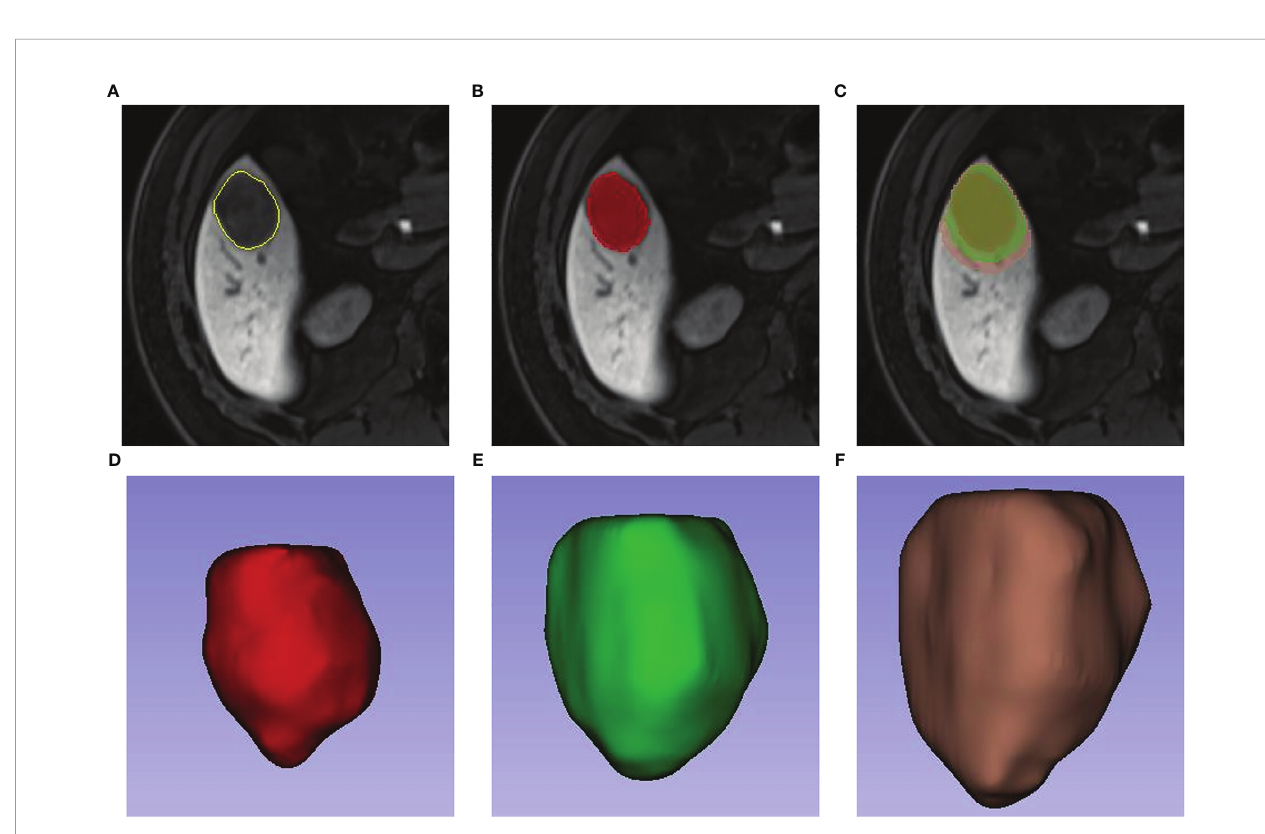
FIGURE 2 | Labeling of tumor lesions and peritumor extension. First, radiologists manually draw the volume(VOI) of the tumor (A, B) . On the bases of VOI entire of the tumor, a region with 10-mm and 20-mm distance to tumor surface were automatically reconstructed (C) . 3-dimensional view of the VOI entire, VOI (tumor & peritumor 10 mm) and VOI (tumor & peritumor 20 mm) respectively were showed in Picture (D – F)